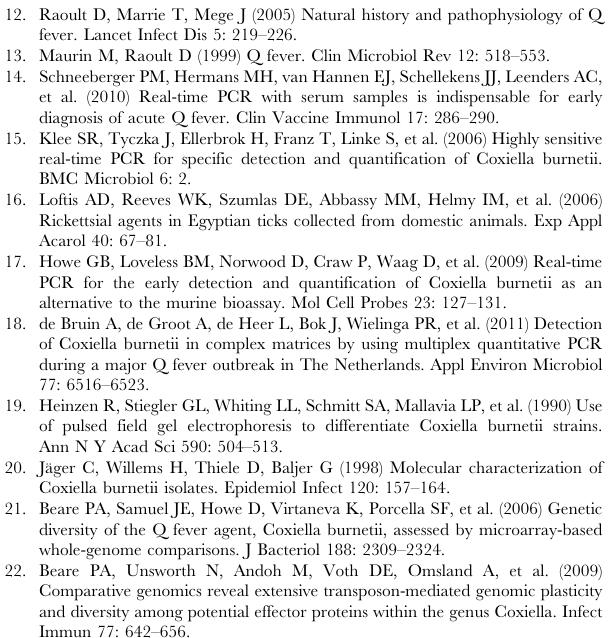
Figure S1 Incidence of Q fever in the Netherlands 2009.